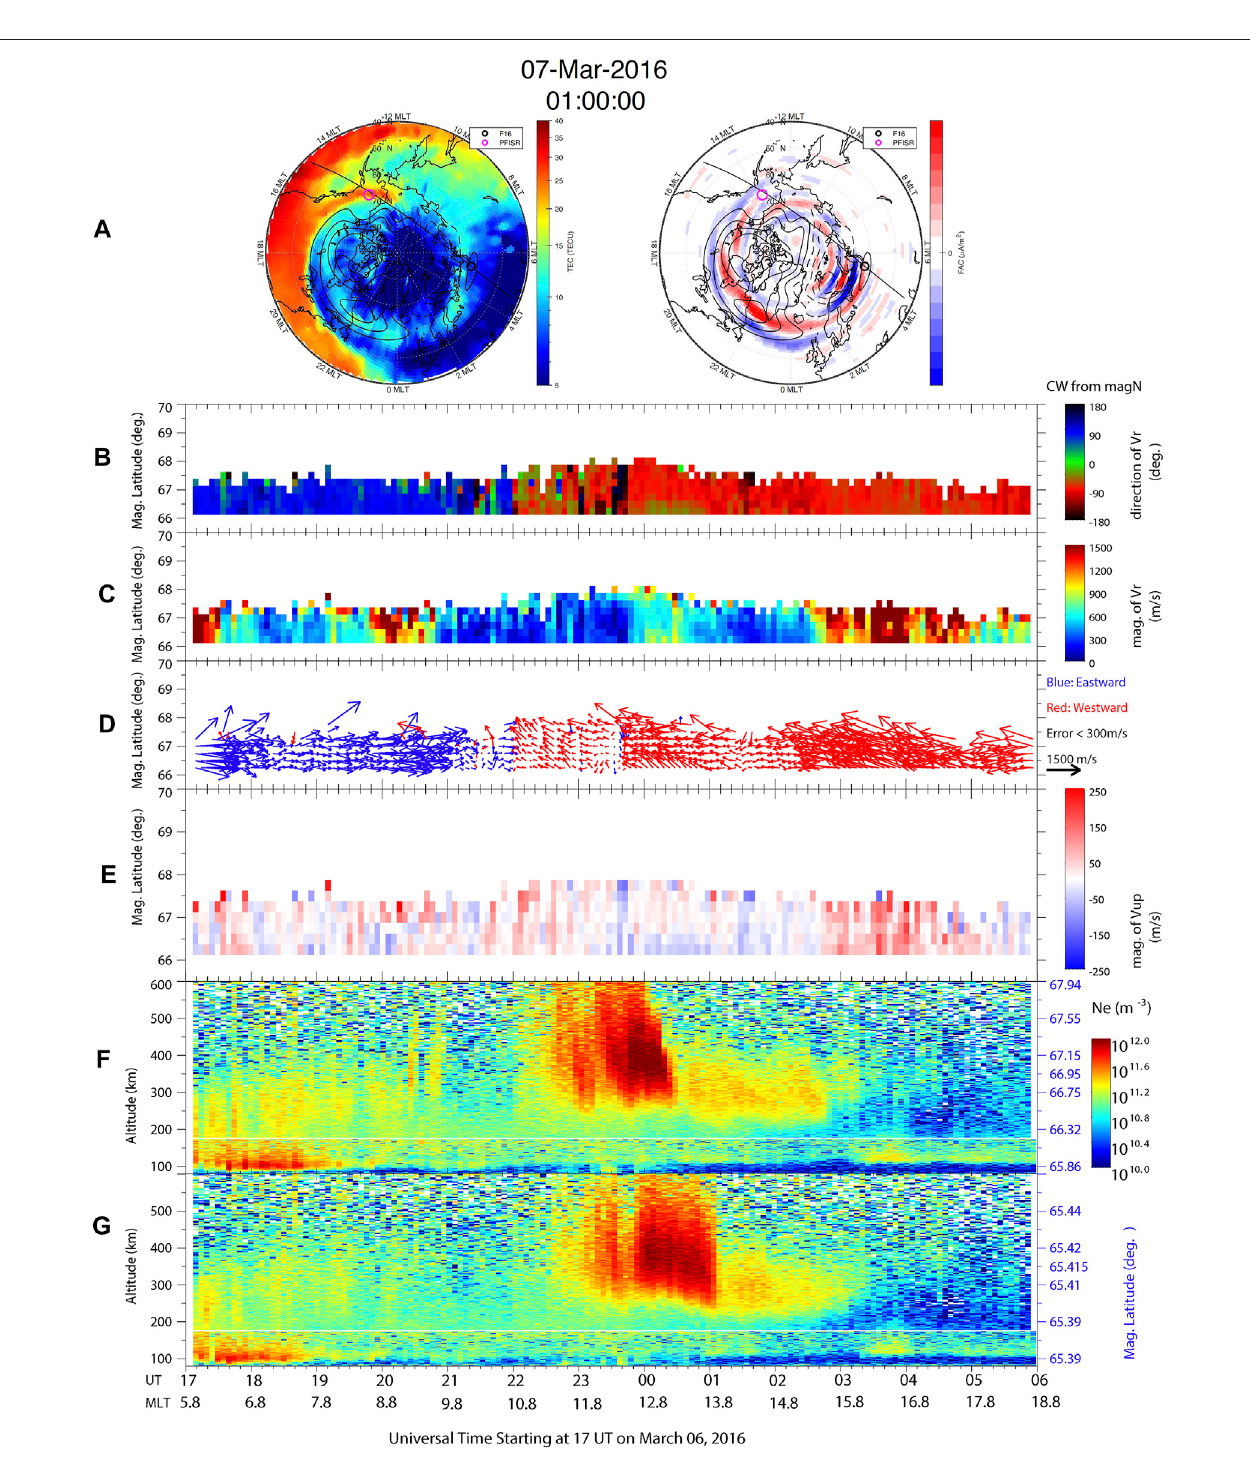
FIGURE5| PFISRobservationsfrom17UTonMarch06to06UTonMarch07.TEC/convection/FACmapsat01UTonMarch07areshownatthetopin (A) .The topthreepanelsshow (B) theconvection fl owdirectionwith0meansnorthwardandpositivemeanseastward, (C) themagnitudeoftheconvection fl ow, (D) vectorplots of the convection fl ows, (E) vertical fl ow due to a combination of the E x B convection and fi eld-aligned fl ow. The bottom two panels show the altitude pro fi les of the ionosphere density observed by beam 4 (F) and beam 2 ( G , fi eld-aligned). The SED plume, its poleward shoulder, and the mid-latitude trough were observed by these two